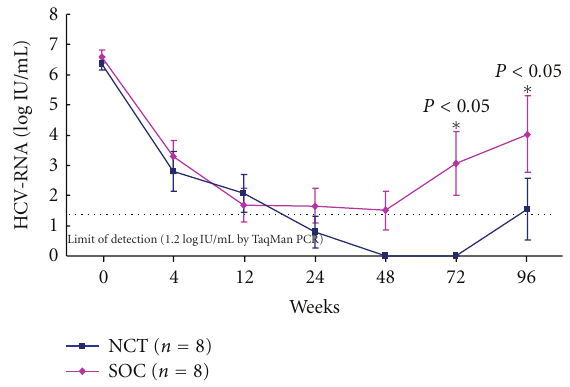
Figure 10: Changes in serum HCVRNA level during the NCT and the SOC in chronic hepatitis C patients with genotype 1 and high viral loads. NCT: novel combination treatment; cyclic and perio- dic IFN treatment (CPIT) consisting of induction treatment with natural interferon- β followed by maintenance treatment with natu- ral interferon- α for 24 wks as induction approach followed by SOC for 48 wks. SOC: standard of care; ribavirin plus pegylated inter- feron α 2b for 48